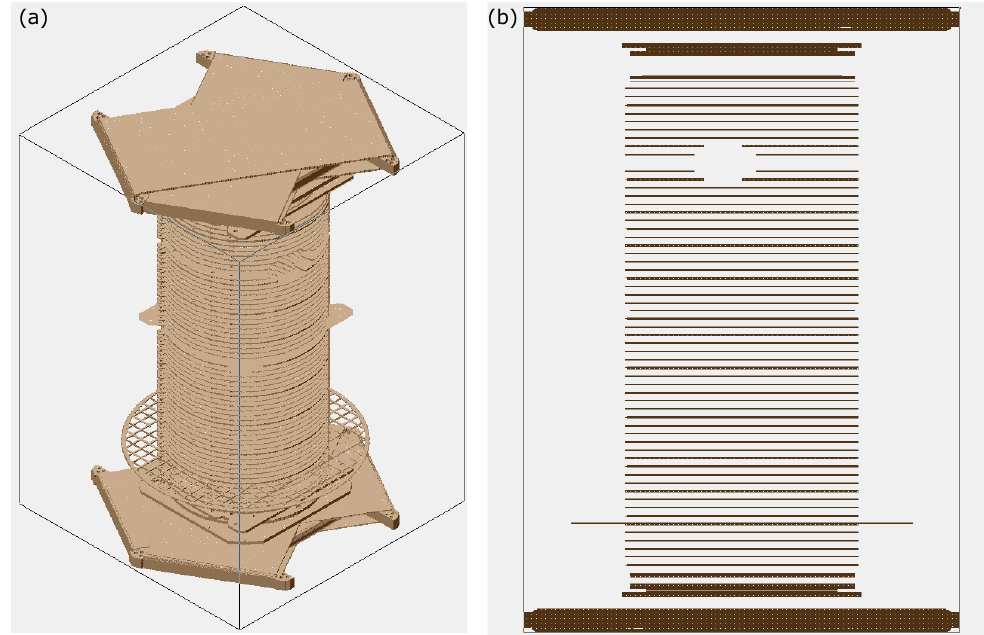
Figure 6. DREAM spectrometer model used by the SIMION simulation. ( a ) 3D isometric display of the model by SIMION. ( b ) Side display of the model by